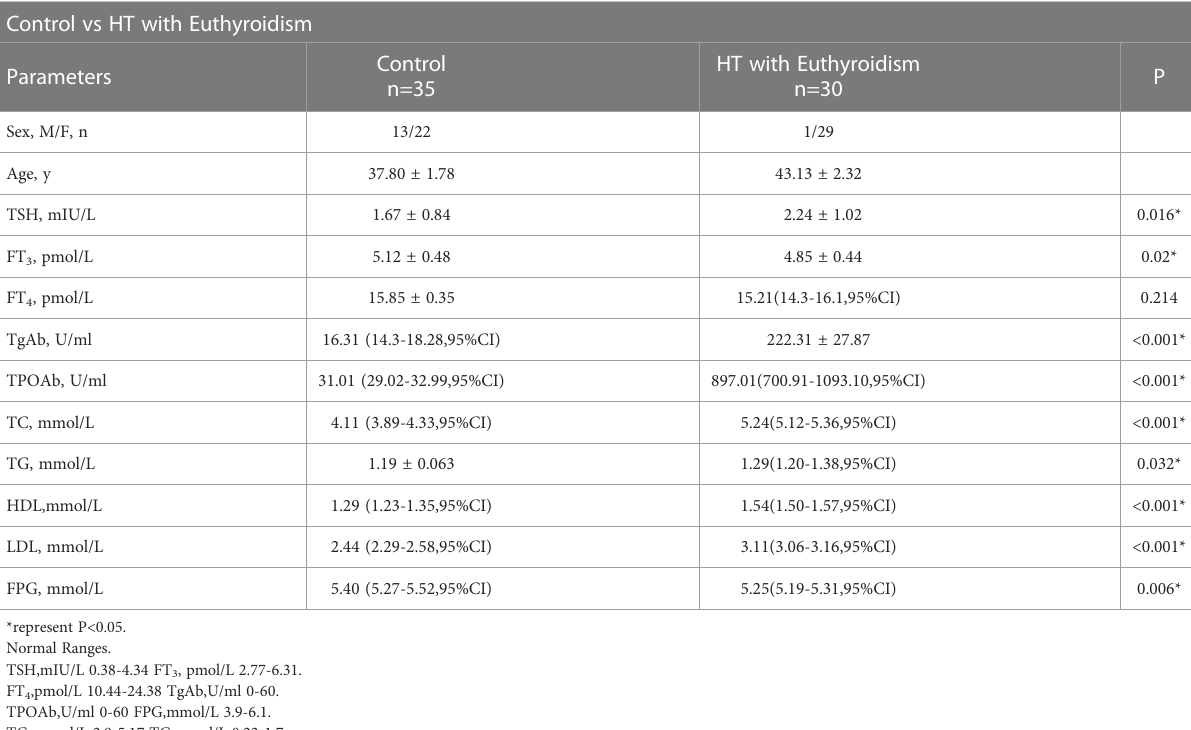
divided via OPLS-DA analysis (R2X =0.203, R2Y = 0.563, Q2 = 0.233, Figure 1D). On account of the screening criteria of variable in fl uences on projection (VIP)>1.5 and P<0.05,21 metabolites were identi fi ed. 10 metabolites were obtained from control group vs HTE group, 8 metabolites were selected from HTE group vs HTS group, 3 metabolites were derived from HTS group vs HTE group (Tables 4.1, 4.2). In the comparison between the control group and HTE group, phosphatidylcholine (PC) 38:6, sphingomyelin (SM) 34:1, lysophosphatidylcholine (LPC) 18:2 sn-1, LPC 18:0 sn-1, LPC 18:1 sn-1, SM 34:2, PC 36:5, PC 34:3, L-Acetylcarnitine and SM 36:2 were higher in HT with euthyroidism patients than healthy (Figure 2A). The heatmap of metabolites was shown in Figure 3A.